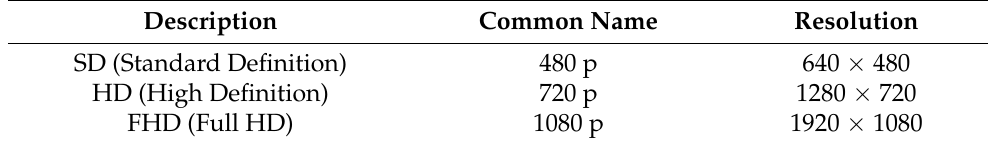
Table 1. High-level video